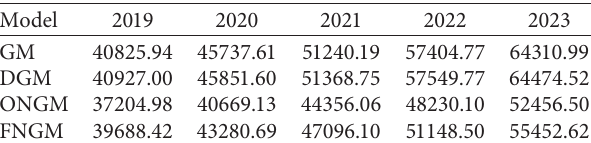
Figure 2: MAPE values generated from four different grey models. Table 6: Forecasting results of China’s natural gas consumption from 2019 to